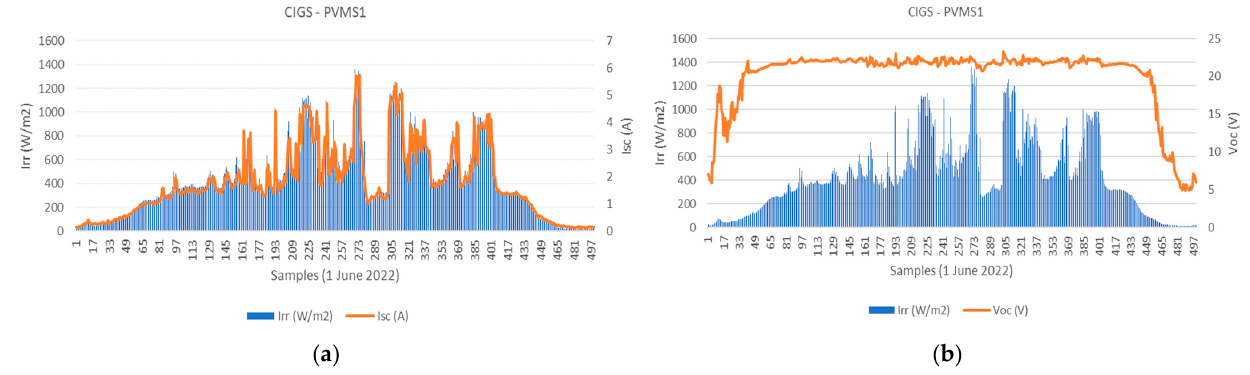
Figure 7. ( a ) Isc/Irr throughout a sunny day and ( b ) VOC/Irr throughout a sunny day.